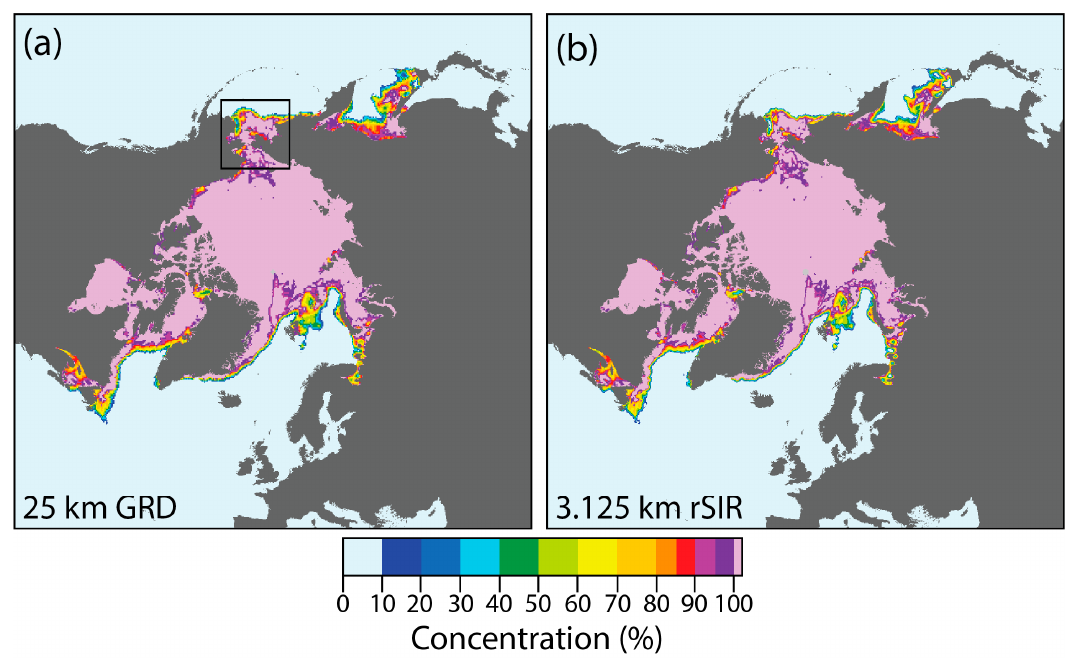
Figure 2. Northern Hemisphere sea ice concentration field from the Bootstrap algorithm for 1 March 2014 from ( a ) 25 km GRD TBs, and ( b ) 3.125 km rSIR brightness temperatures (TBs).